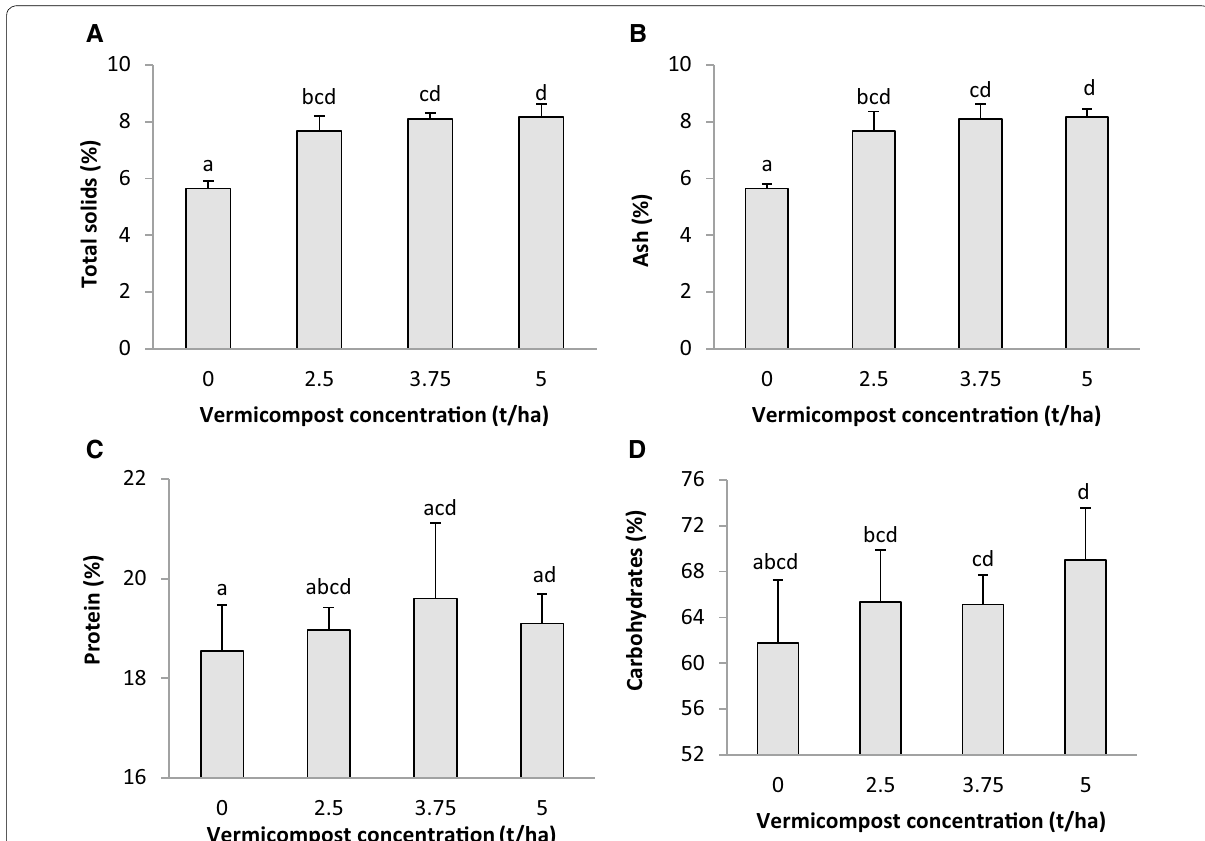
Fig. 2 Effect of parthenium vermicompost on A totals solids, B ash content, C protein content, and D carbohydrate content of ladies finger pods. The standard deviation is indicated on the chart. Results which do not differ significantly (LSD test; p < 0.05) carry at least one character in the superscript which is